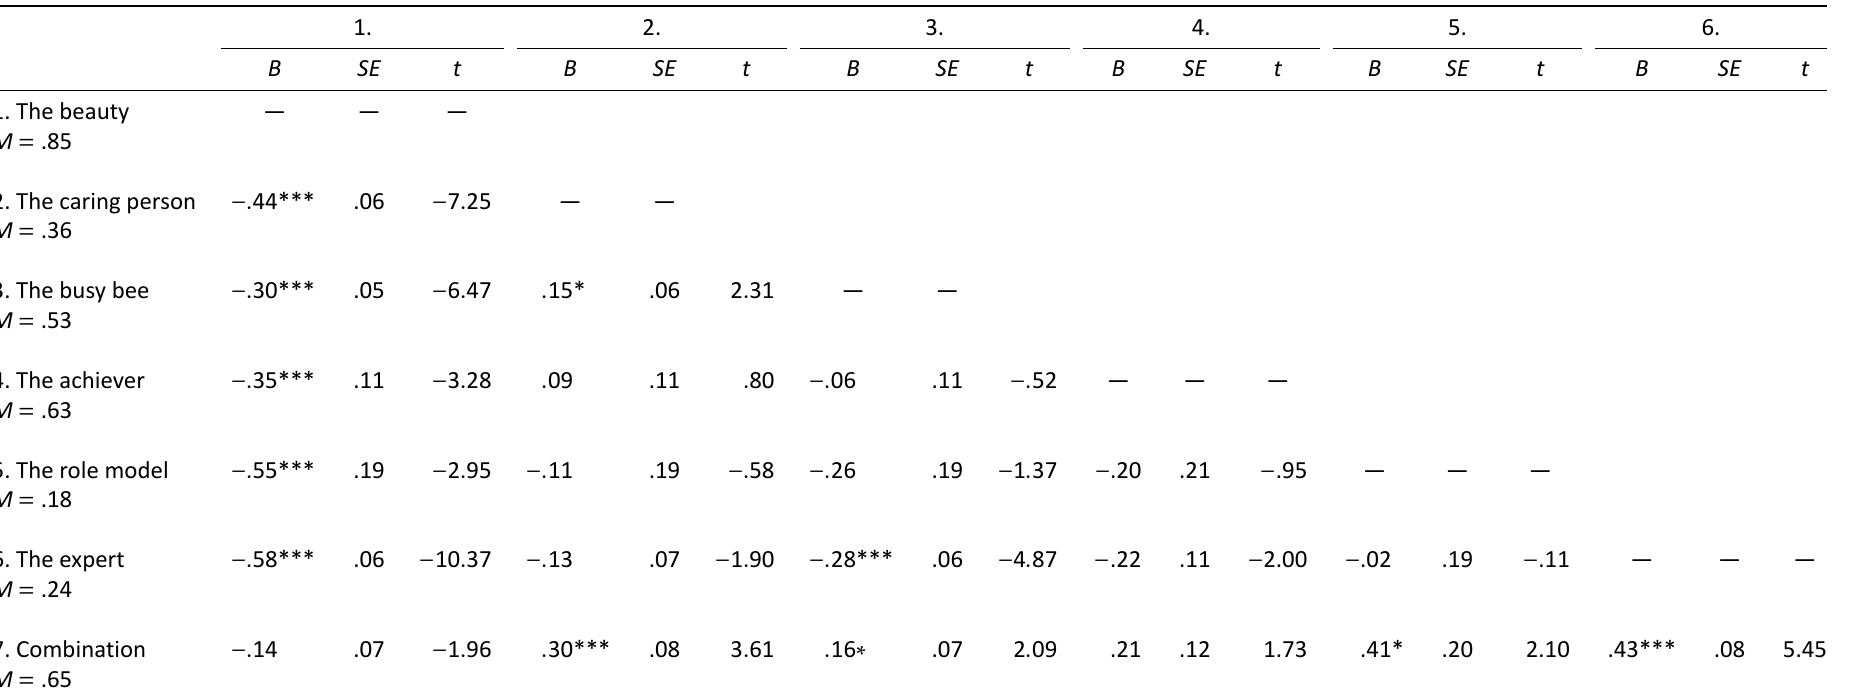
Table 1. Differences in sexualization between